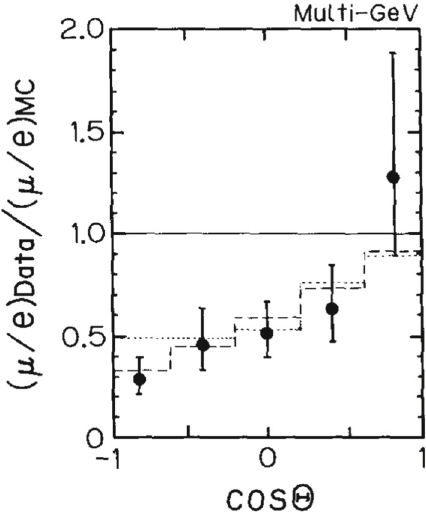
Fig. 7 Zenith angle distribution and comparison with an expectation without oscillation [10]